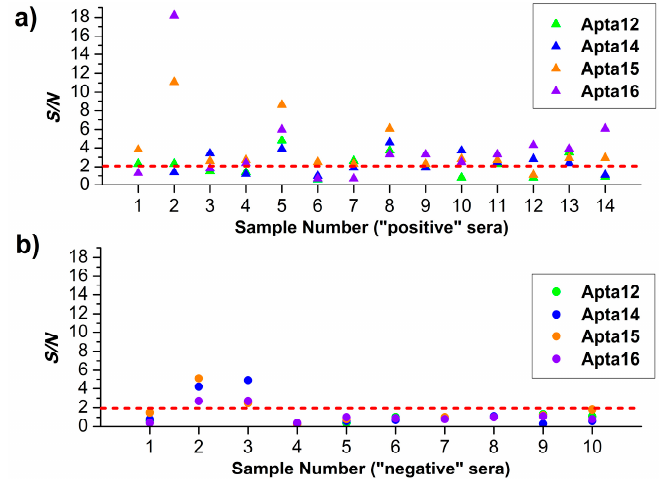
Figure 4. S/N values obtained after the incubation of the apta-based AFM chip with ‘positive’ ( a ) and ‘negative’ ( b ) serum samples calculated for working sensor areas with the following immobilized aptamers (color indicates aptamer type): A12 (green); A14 (blue); A15 (orange); and A14 (violet). Red dashed line indicates cut-off S/N value.